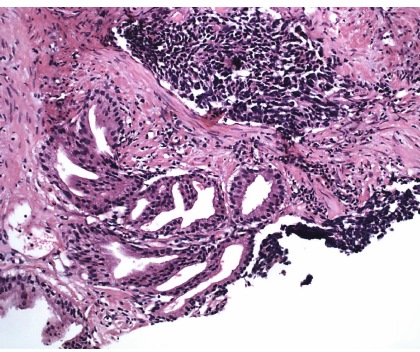
Figure 2: Combined acinar adenocarcinoma and small cell carci- noma diagnosed in a needle biopsy.